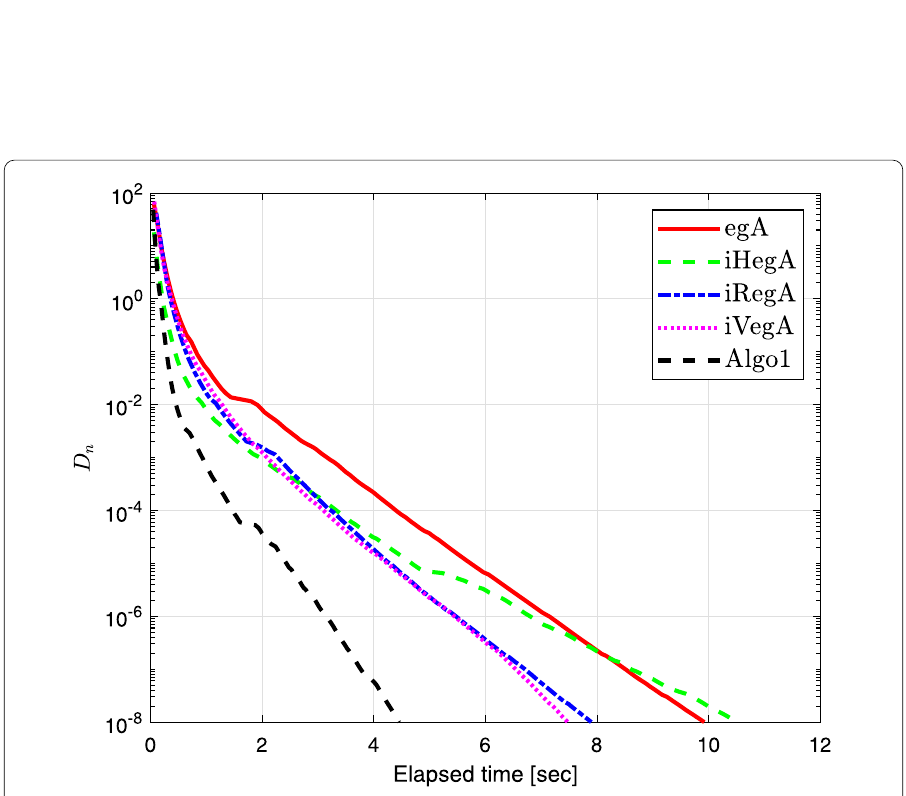
Figure 4 Example 5.1 when n = 400: the number of iterations is 165, 163, 146, 143, 129,